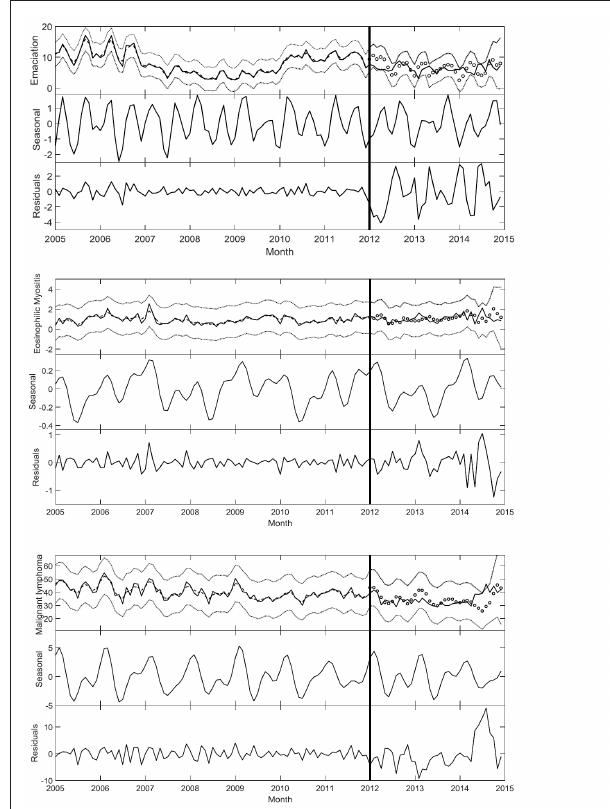
FigUre 7 | Results of the three Dynamic Harmonic Regression (DHR) models for the carcass condemnation rate [i.e., emaciation (top), eosinophilic myositis (middle) and malignant lymphoma (bottom)] in California from Jan-2005 to Dec-2014. The subplot at the top presents the model simulation results (in dashed line) from Jan-2005 to Dec-2011, the data (solid line) and the two times SE bounds (dotted lines) from Jan-2005 to Dec-2014 and, the 3 month ahead DHR model predictions from Jan-2012 to Dec-2014. The other two subplots present the seasonal component from Jan-2005 to Dec-2014 and the residuals extracted using the discrete-time white noise (Equation 1) from 2005 to Dec-2011 and the prediction error from Jan-2012 to Dec-2014